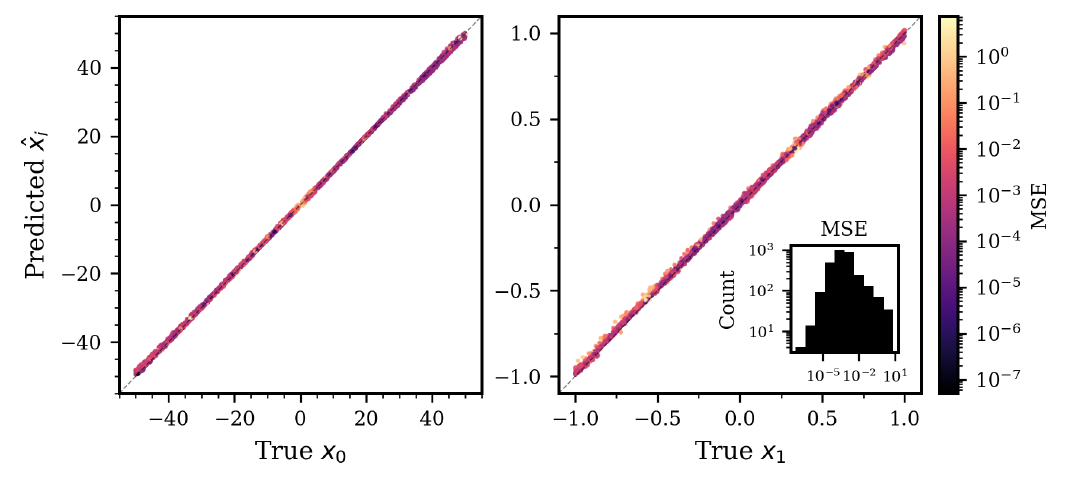
Figure 4: True Stevens coefficients x versus predicted coefficients ˆ x i group m¯3m and J = 4. The network was trained with the five thermodynamic data ( b ) , χ ( t ) , c ( t ) } for T = { 1,17,300 } K. We choose the high-symmetry sets { µ α z , T α i z i M i direction z = [ 001 ] . The Stevens coefficients are predicted with MAEs given by MAE ( 0 ) = 0.321 K and MAE ( 1 ) = 0.012. The inset and color coding show the MSE of each data point, which lies at 〈 MSE 〉 = 0.053 on